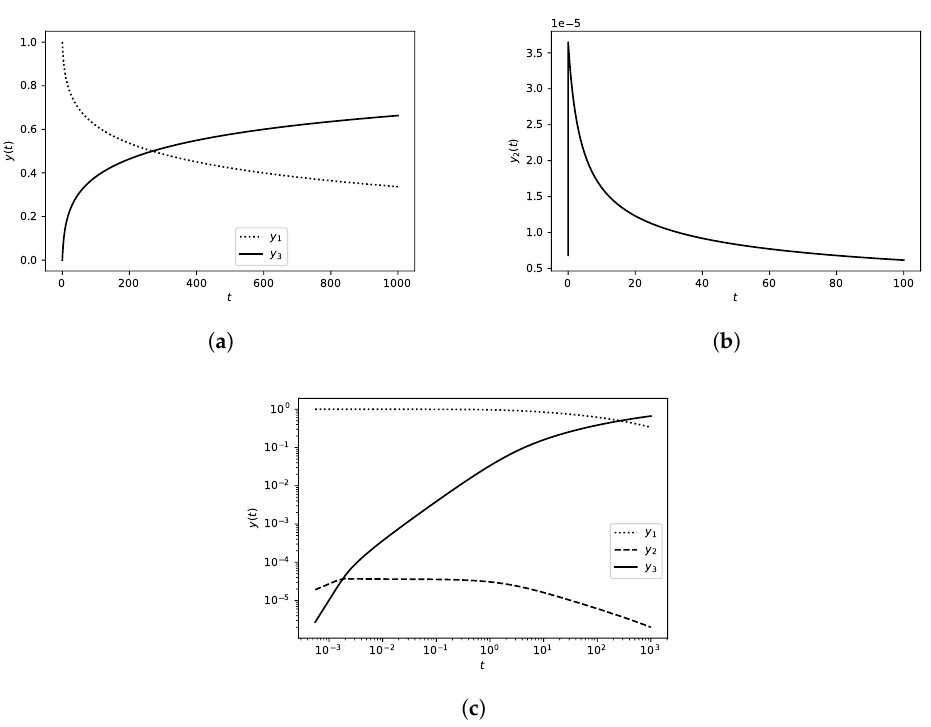
Figure 8. Solution profiles of Example 4 with m = 3 and h = 0.001. ( a ) concentrations of y 1 and y 3 ( b ) concentrations of y 2 ( c ) concentration y 1, y 2 and y